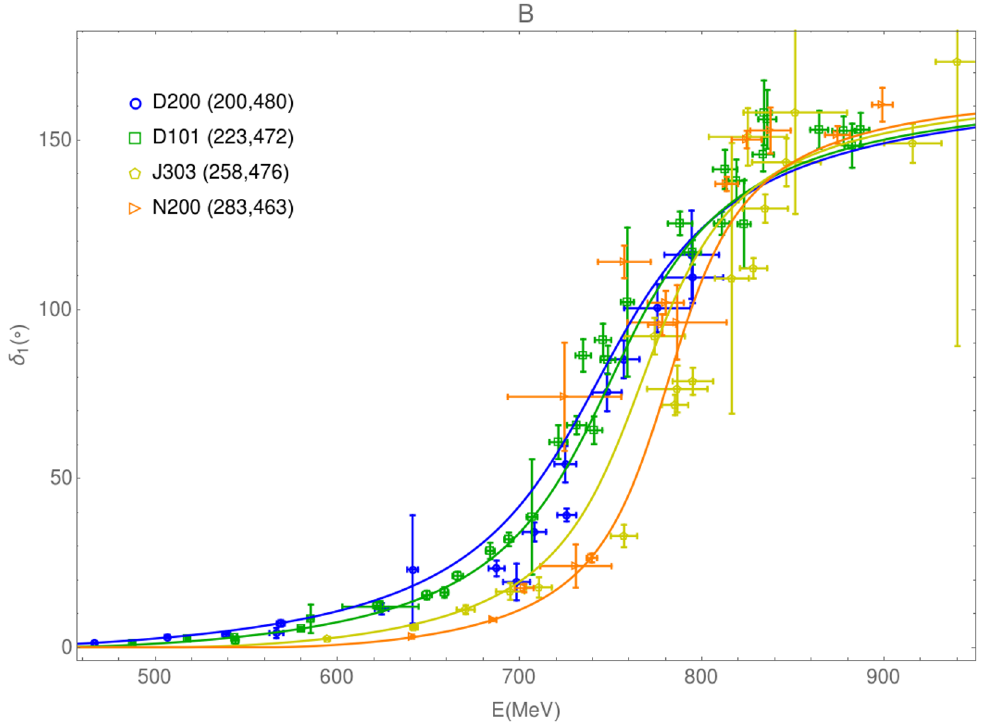
Figure 8 . Phase shift lattice data in comparison with the result of Fit III B (global (cid:12)t of Tr M = c lattice data with scaling method